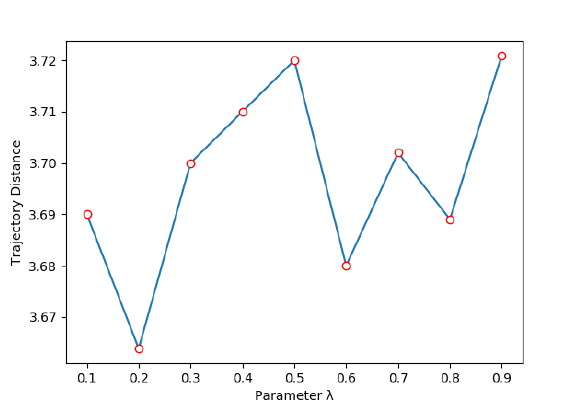
Figure 5. The first four rows are the origin algorithm AGN ; the last two rows are AGN [ 1 ] train- ing in raw observation space. Given initial observation and goal observation, AGN can attain valid trajectories.